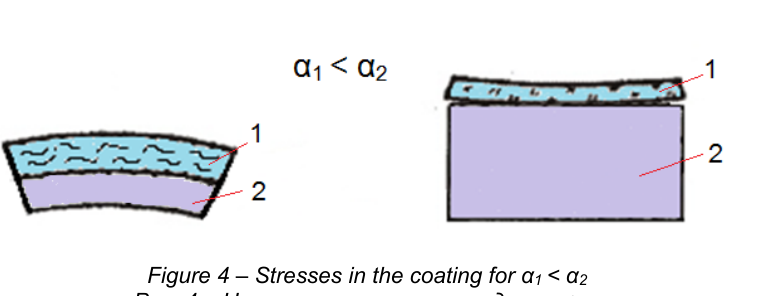
Figure 4 – Stresses in the coating for α 1 < α 2 Рис . 4 – Напряжения в покрытии для α 1 < α 2 Слика 4 – Напони у превлаци за α 1 < α